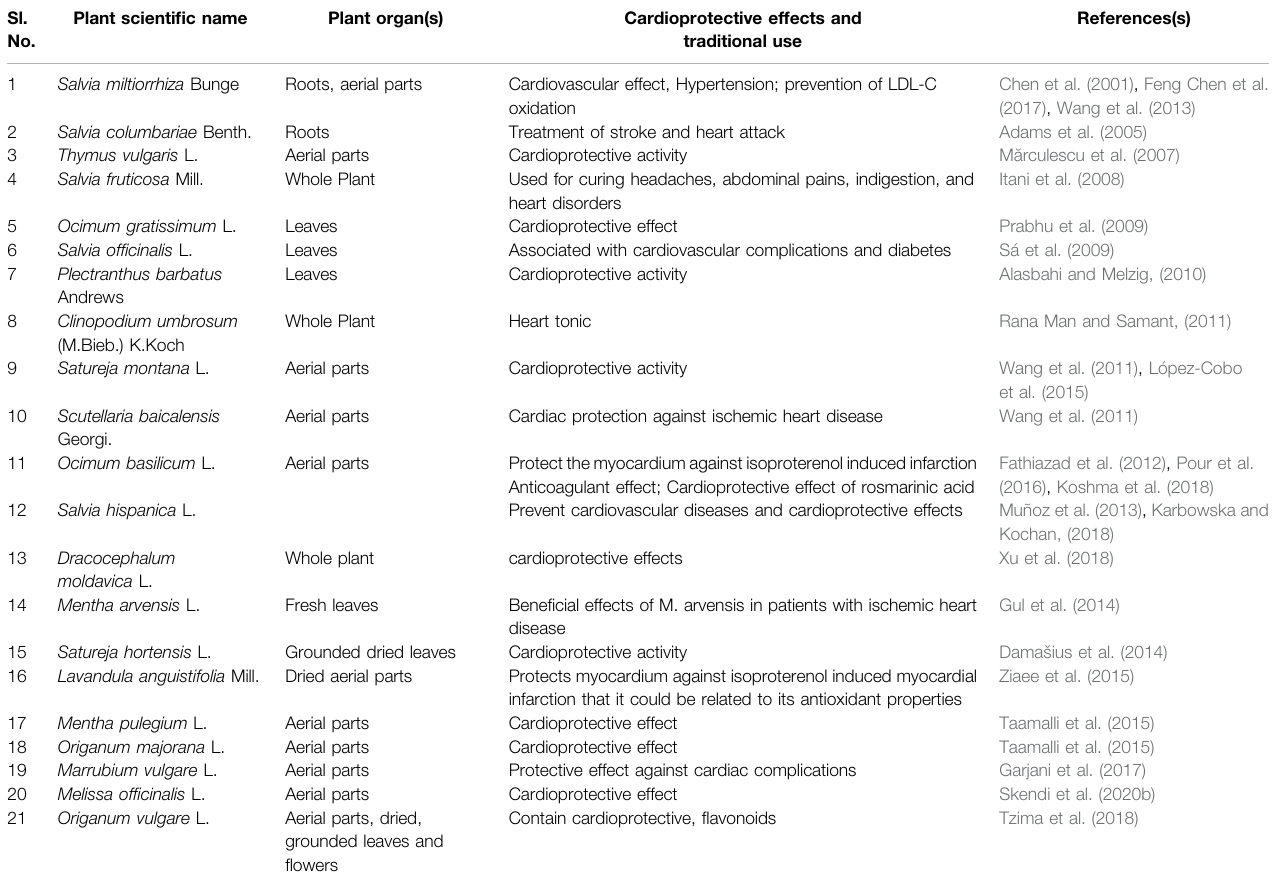
TABLE 3 | List of Lamiaceae species derived functional foods as cardio protective. Sl.